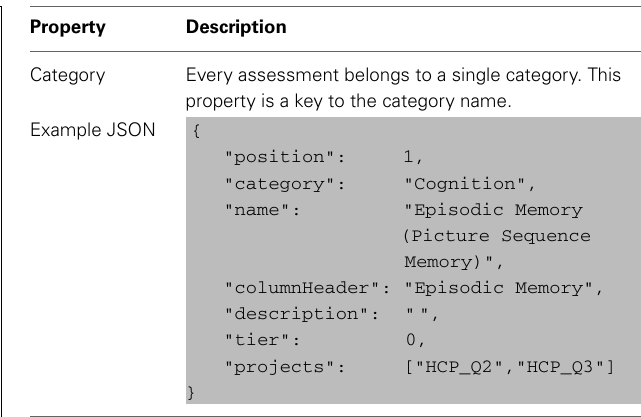
Table 3 | Defining assessment node-type properties in